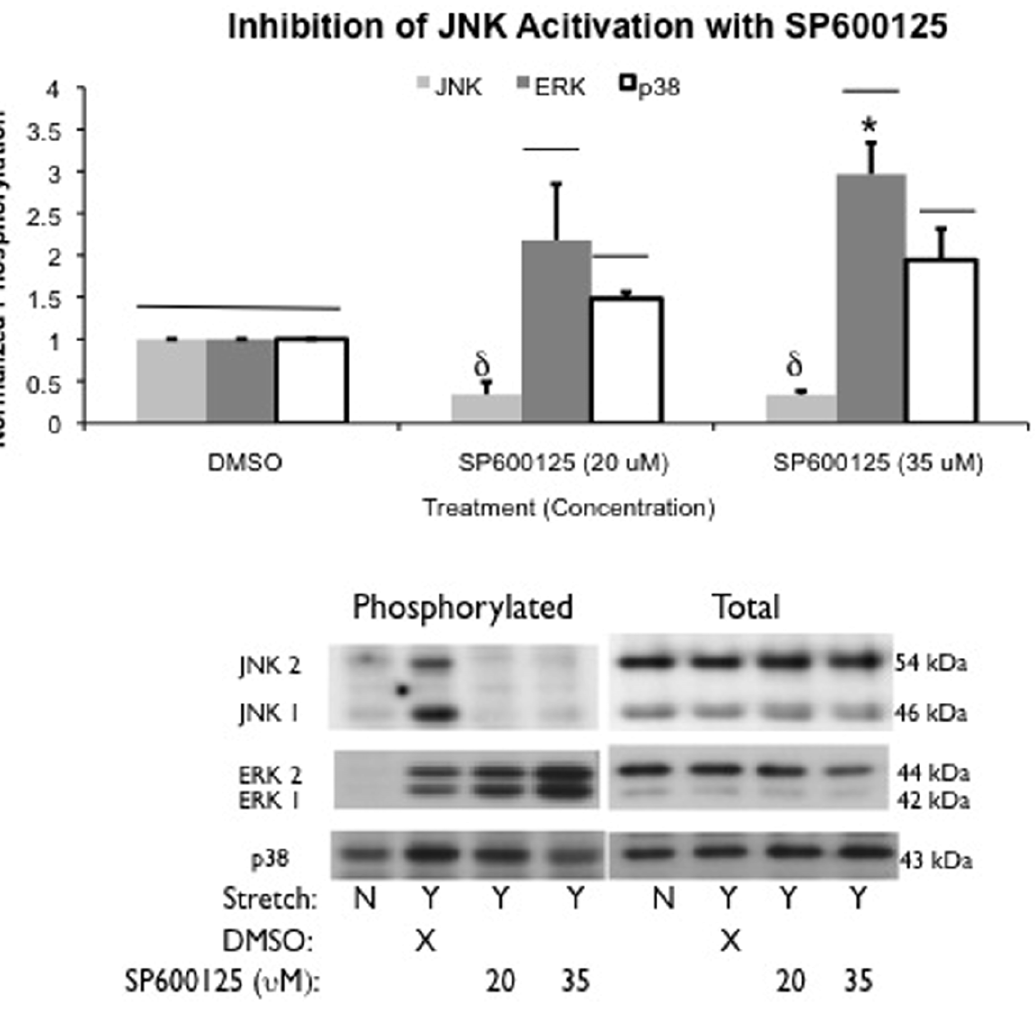
Figure 2. SP600125 inhibits JNK phosphorylation. Phosphorylation levels of JNK, ERK, and p38 MAPk following treatment with the inhibitor SP600125 (20 or 35 m M) or the control DMSO and 10 minutes of cyclic stretch at a rate of 0.25 Hz to a peak magnitude of 37% D SA normalized